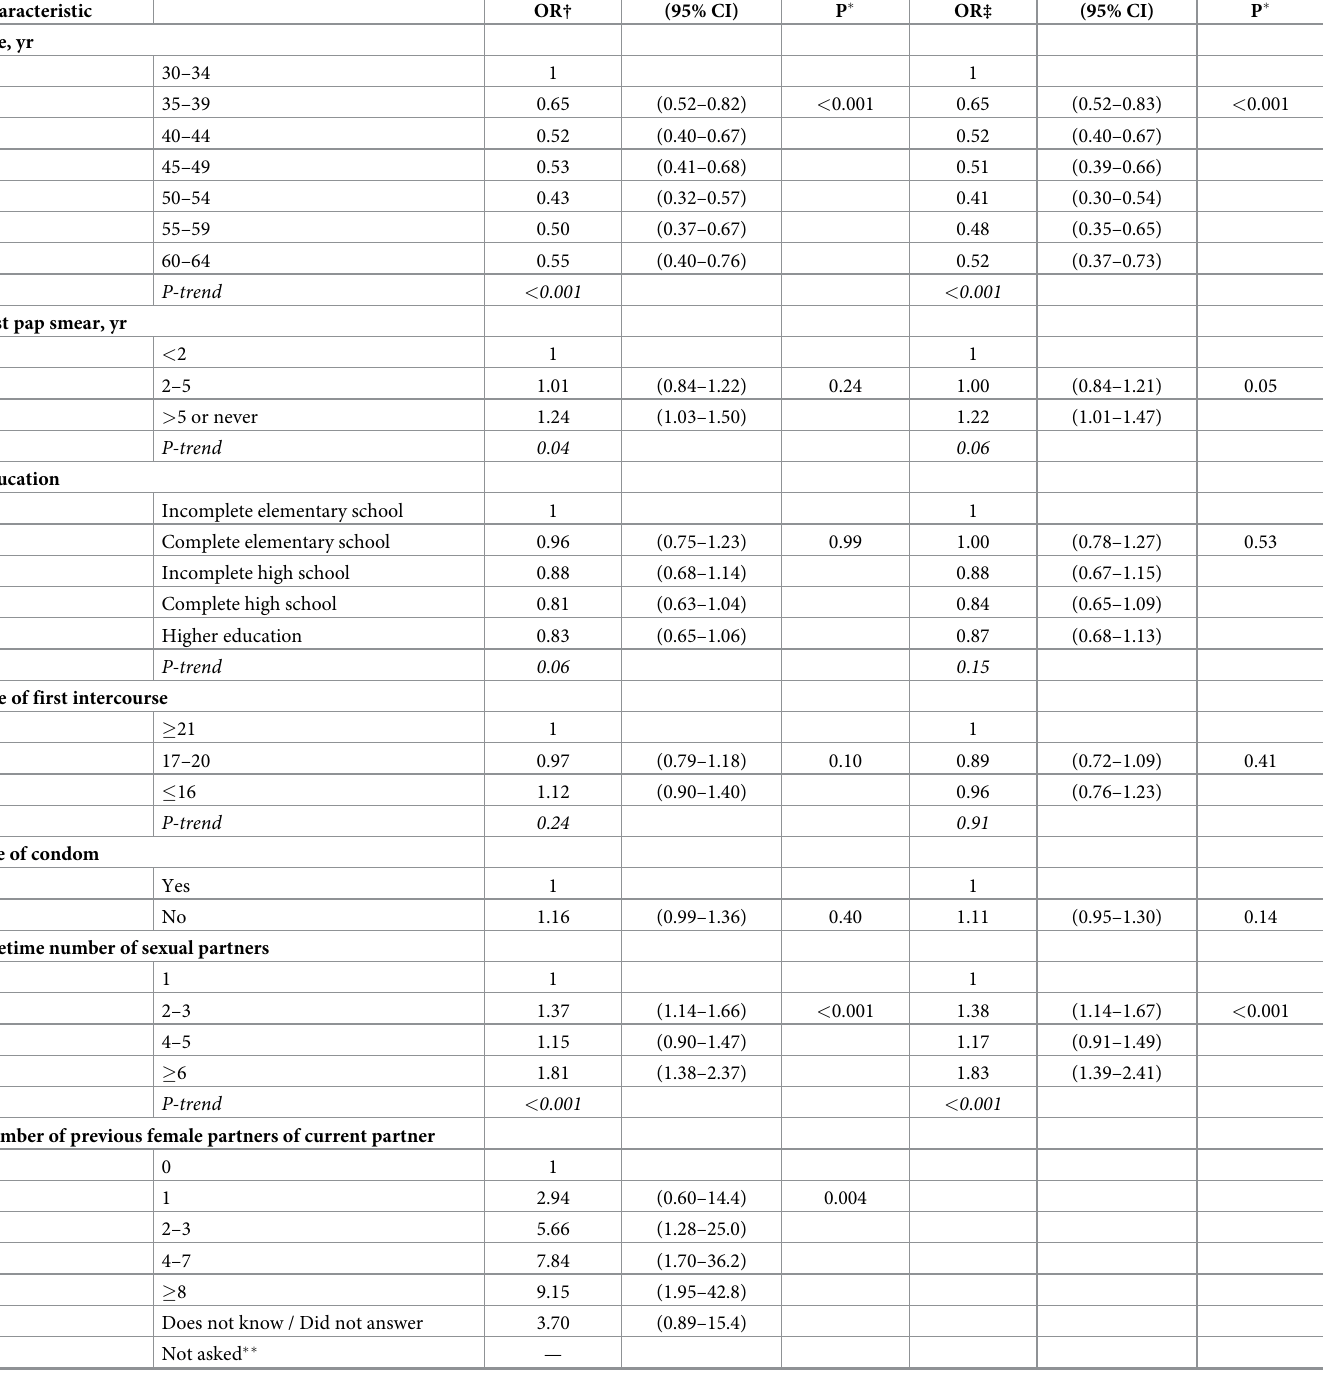
Table 3. Odds ratios of hrHPV associated with sociodemographic characteristics and selected risk factors among 30-69-year-old women from the Central Depart- ment, Paraguay.